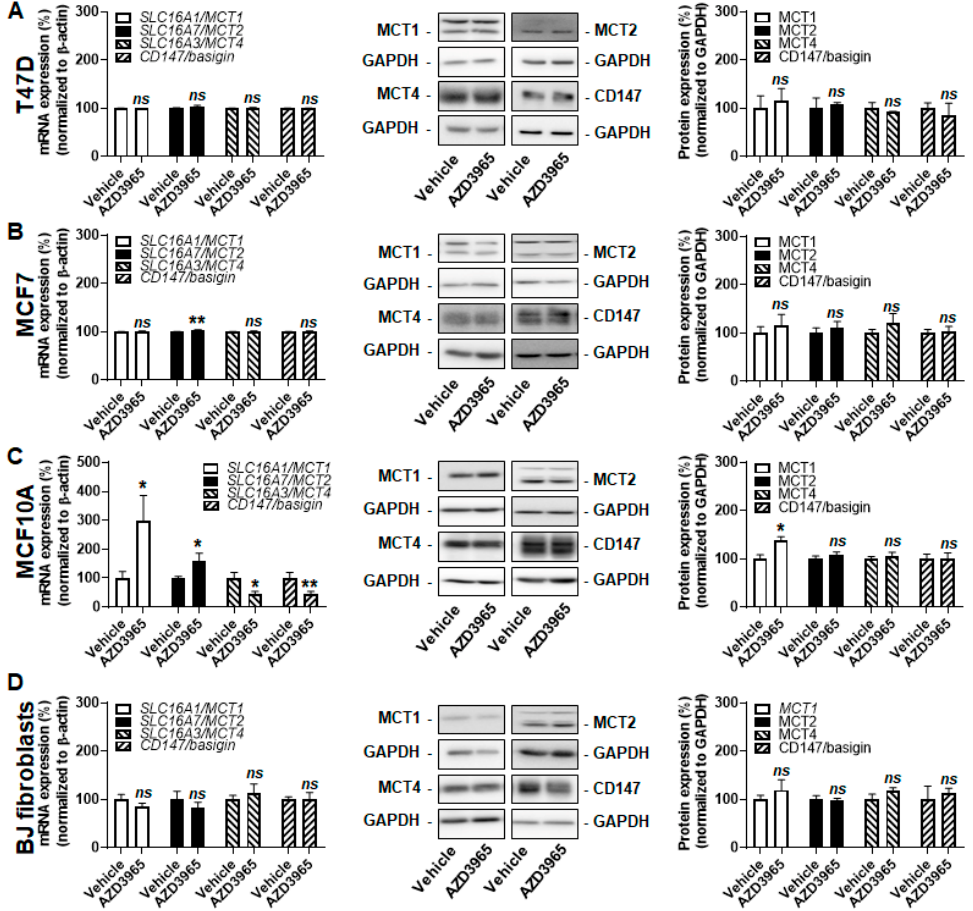
Figure 2. AZD3965 induces minor changes in the monocarboxylate (MCT) repertoire of breast-associated malignant and nonmalignant cells when lactate is used as an oxidative fuel. ( A – D ) Cells were assayed in medium containing 10 mmol/L sodium L -lactate, no glucose, no glutamine and 1% FBS. ( A ) mRNA (left panel) and protein (middle and right panels) expression of MCT1, MCT2, MCT4 and CD147/basigin in T47D cells treated for 24 h ± 10 µM AZD3965 ( n = 3–9 for RT-qPCR, n = 3 for WB). ( B ) As in A, but using MCF7 cells ( n = 9 for RT-qPCR, n = 3–11 for WB). ( C ) As in A, but using MCF10A cells ( n = 9–26 for RT-qPCR, n = 3–6 for WB). ( D ) As in A, but using BJ fibroblasts ( n = 8–21 for RT-qPCR, n = 3–6 for WB). All data are shown as means ± SEM. * p < 0.05, ** p < 0.01, ns p > 0.05 compared to vehicle; by Student’s t test ( A – D ).